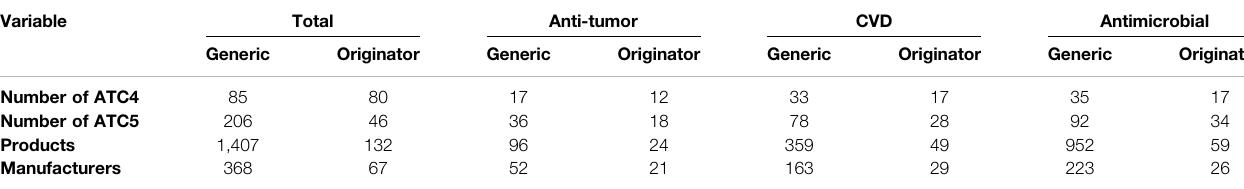
TABLE 1 | Sample size and distribution by therapeutic